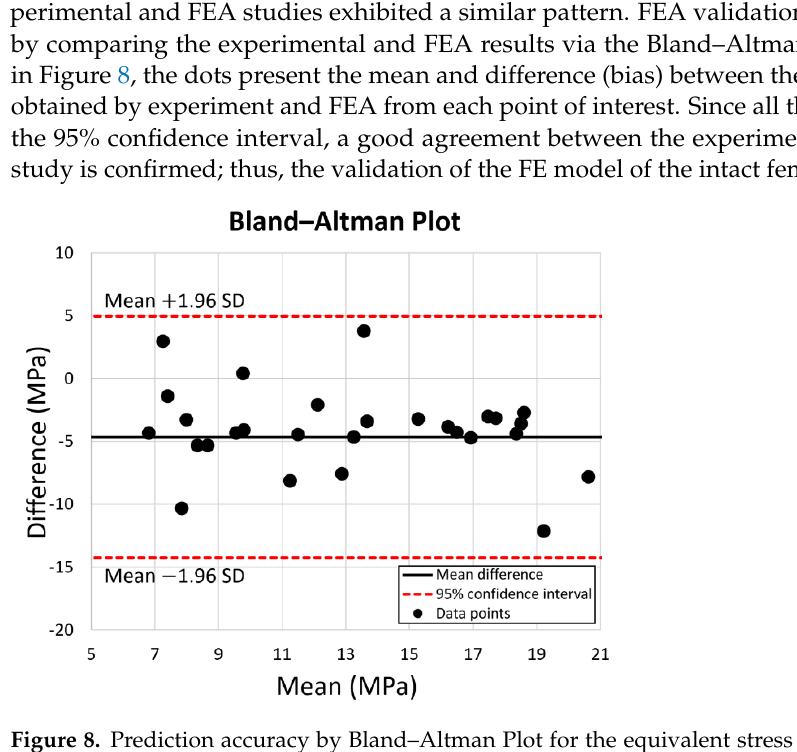
Figure 8. Prediction accuracy by Bland – Altman Plot for the equivalent stress for the 10 points of interest on the intact bone, the PEEK stem, and the Ti6Al4V stem. The red dotted lines represent the 95% confidence interval.